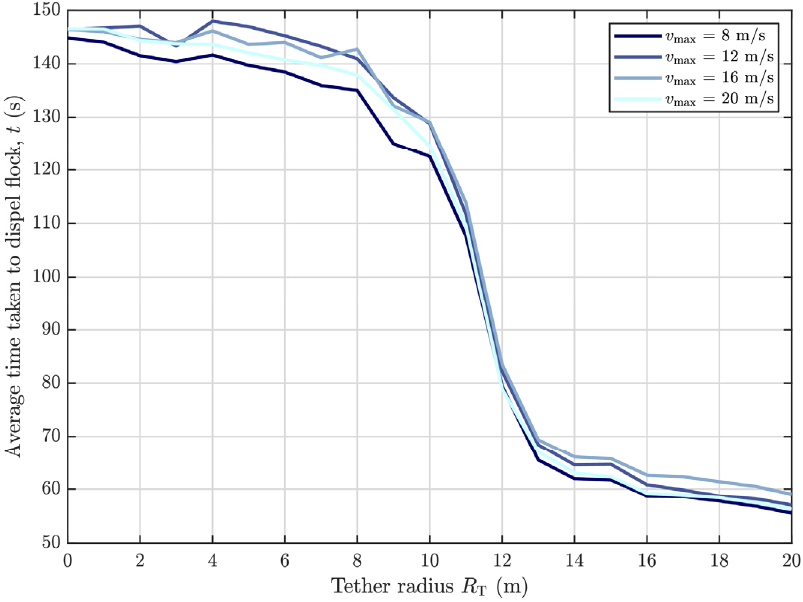
Figure 14. Impact of UAV maximum speed on time deterrence for a configuration of n = 4 agents. Darker lines indicate lower maximum speed.